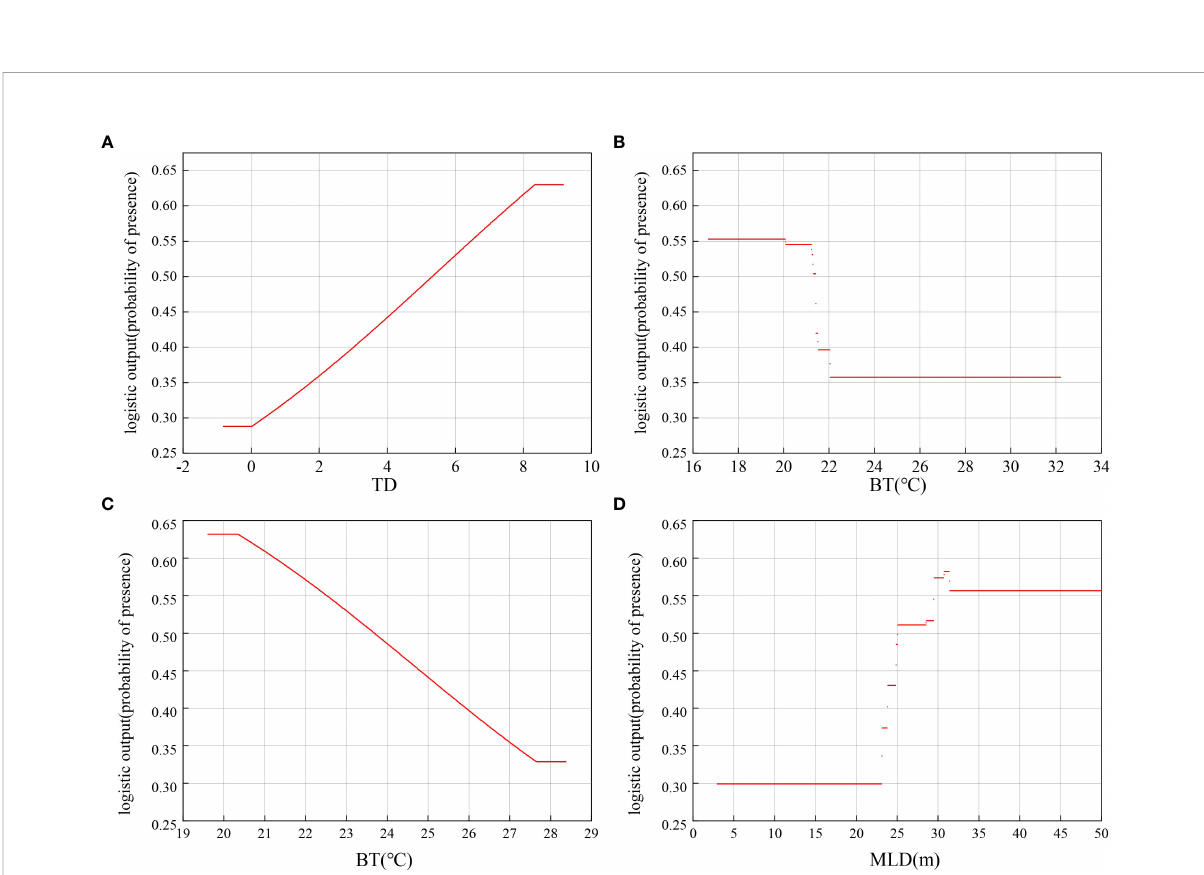
FIGURE 4 Relationship between the top environmental predictors and the probability of presence of Trichiurus japonicus in the Beibu Gulf under MaxEnt modeling of the current scenario: (A) spring temperature difference between surface and bottom water (TD); (B) summer bottom water temperature (BT); (C) autumn BT; (D) winter mixed layer depth